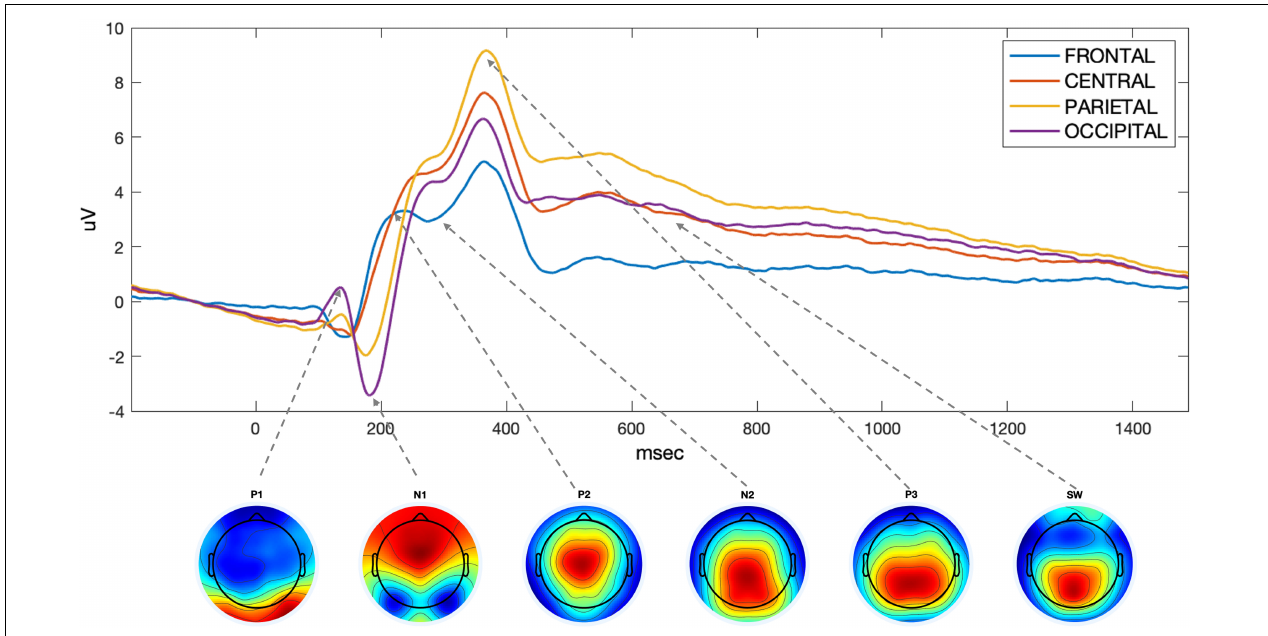
FIGURE 4 | Time-course of the ROIs selected to measure ERP components. Below, topographies of the components considered, with the arrow linking them to the corresponding peak on the ROIs time course.